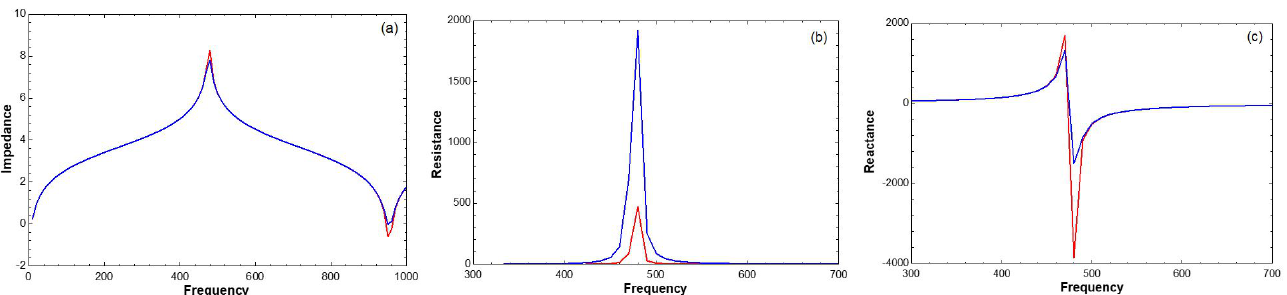
Figure 2. Demonstration of similarity between the chain matrix and transmission line impedance calculation methods for a hard walled 17.5 cm long tube with constant 1 cm 2 cross-sectional area. Impedance, resistance, and reactance are in units of dyne-s/cm 5 and frequency is in Hz. The resistance and reactance plots have a frequency range of 300–700 Hz to highlight resonance and each asymptotically approach 0 resistance and reactance from both directions. Calculations done with the chain matrix method are red lines and those done with the transmission line method are blue for the following values: ( a ) Impedance ( b ) Resistance ( c )